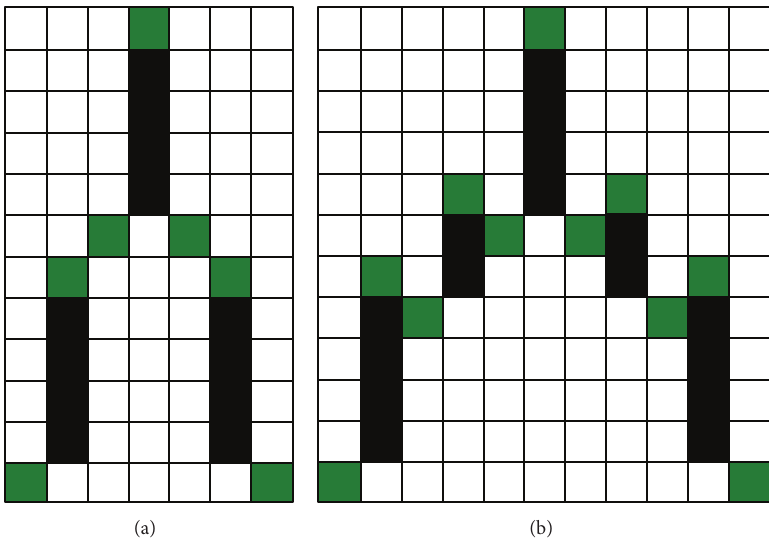
Figure 8: (a) Basic function for radius 2 ; (b) basic function for radius 4